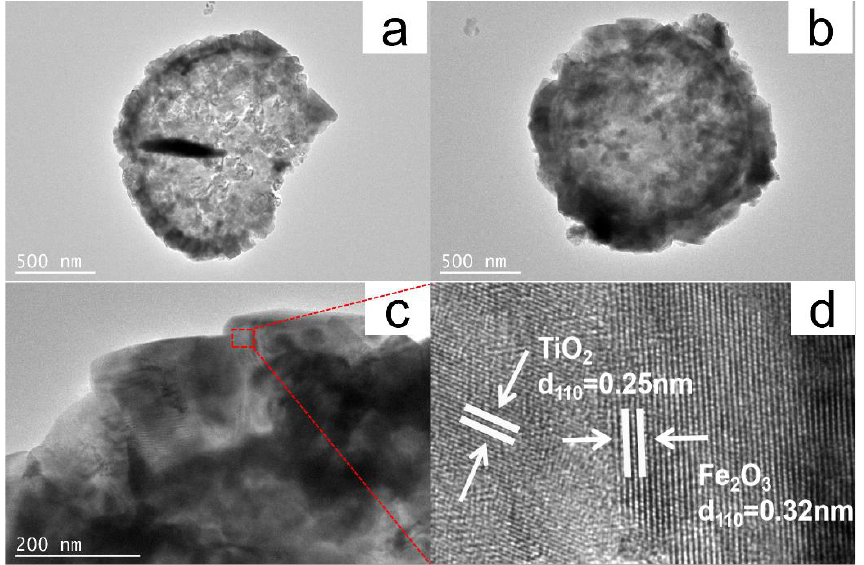
Figure 5. ( a – c ) Low and high magnification TEM images and ( d ) HR TEM image of α -Fe 2 O 3 /RT (0.025 mM).